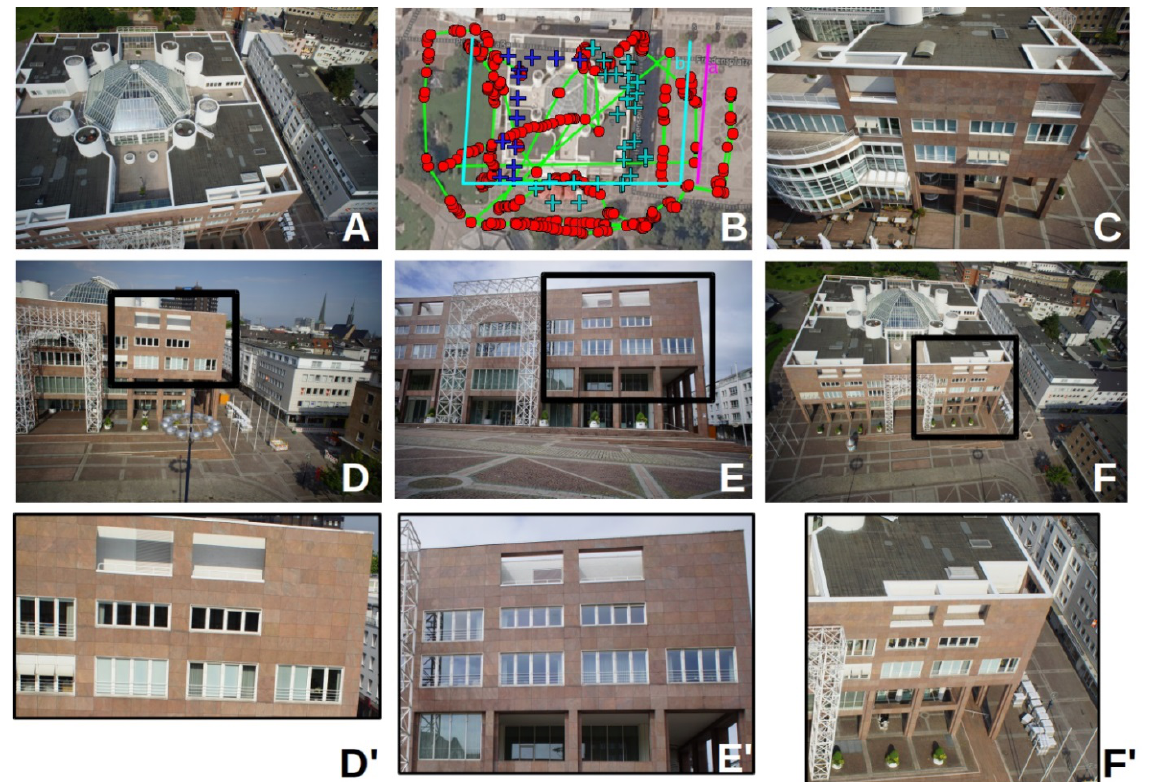
Figure 1: Overview on benchmark dataset. A,C,D,F: UAV images from different locations and under different angles, B: GPS- based image position approximations overlaid on google earth view (red dots), GCP/CPs (crosses), magenta and turquoise lines: used facades for software test, section 4, subset a and b, respectively, E: terrestrial image. D’, E’, F’: cut outs of the respective